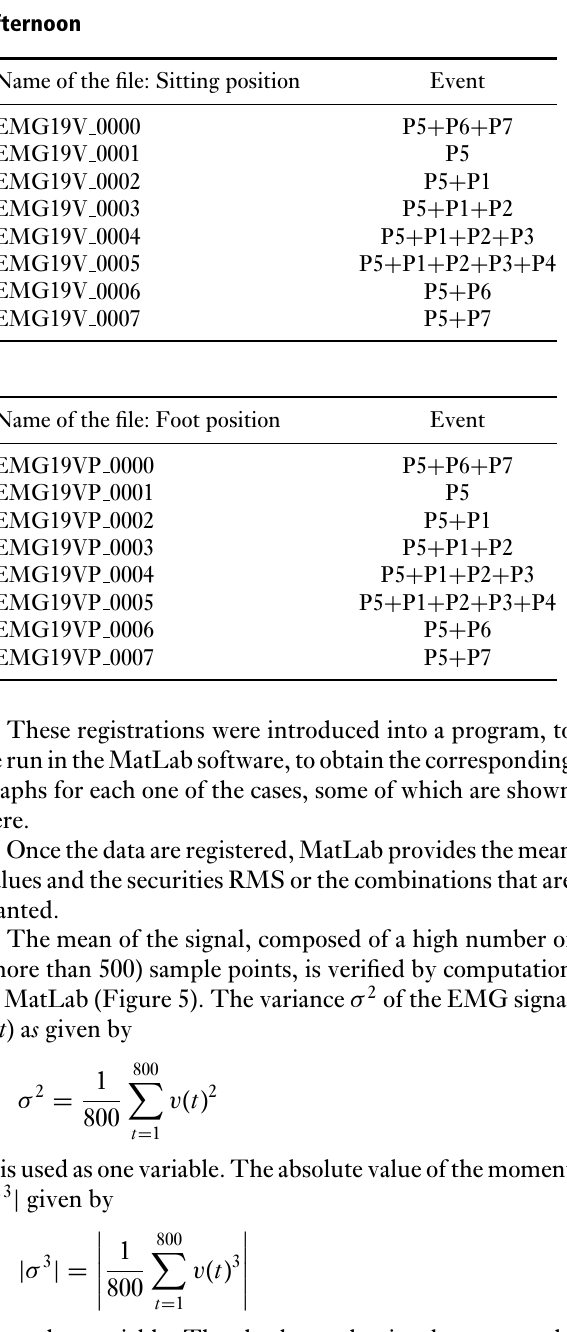
In most motions, the variance and ZC information are grouped in separable clusters that may be approximated by Gaussian densities, and their moments represent the